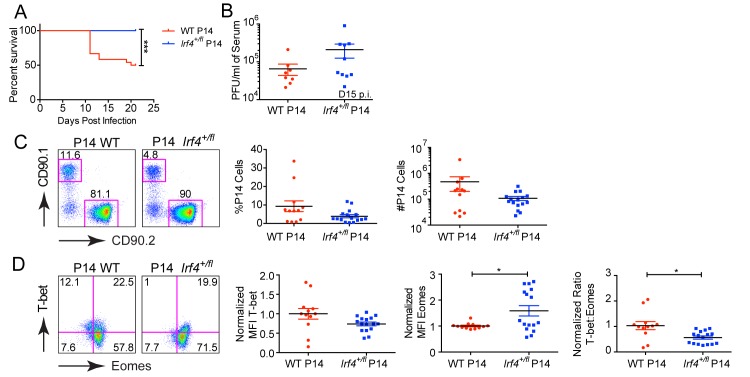
Cell-intrinsic role of IRF4 in regulating the balance of T-bet to Eomesodermin expression in CD8+ T cells responding to LCMV-clone 13 infection.104 CD90.1 WT P14 cells or CD90.1 Irf4
+/fl P14 cells were transferred into CD90.2 CD4-Cre+ host mice and one day later recipients were infected with LCMV-clone 13. (A) Survival curve showing % survival of recipient mice that received either WT or Irf4
+/fl P14 cells over 22 days. Data are a compilation of three independent experiments. (B) Serum was harvested from recipient mice at D15 post infection and virus titers were determined by plaque assay. Each data point represents an individual mouse and data are a compilation of two independent experiments. (C) Dot plots show CD90.1 (transferred cells) versus CD90.2 (host cells) staining on gated live CD8+ T cells (left). Graphs show compilations of proportions and numbers of transferred P14 cells at D22 post-infection (right). Each data point represents an individual mouse and data are a compilation of three independent experiments. (D) Dot plots show T-bet versus Eomes staining on gated live CD90.1+ CD8+ T cells (left). Graphs show the normalized MFI of T-bet and Eomes, each normalized to the average of P14 WT transferred samples and the ratio of the normalized MFIs for T-bet relative to Eomes, (right). Each data point represents an individual mouse and data are a compilation of three independent experiments. Statistical analysis was determined by Log-rank (Mantel-Cox) test (A) or unpaired t test with Welch’s correction (B-D).